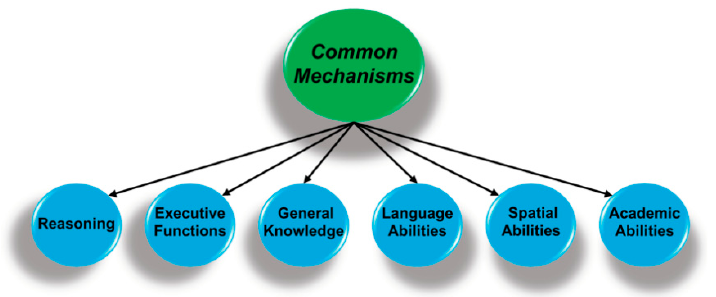
Figure 2. Performance on perceptual, cognitive, and academic measures are hierarchically organized, with specific abilities (not shown) at the lowest level that are organized as clusters of related abilities (above). The key finding is that performance is correlated across all domains and suggests there are mechanisms that are common to all forms of cognition.